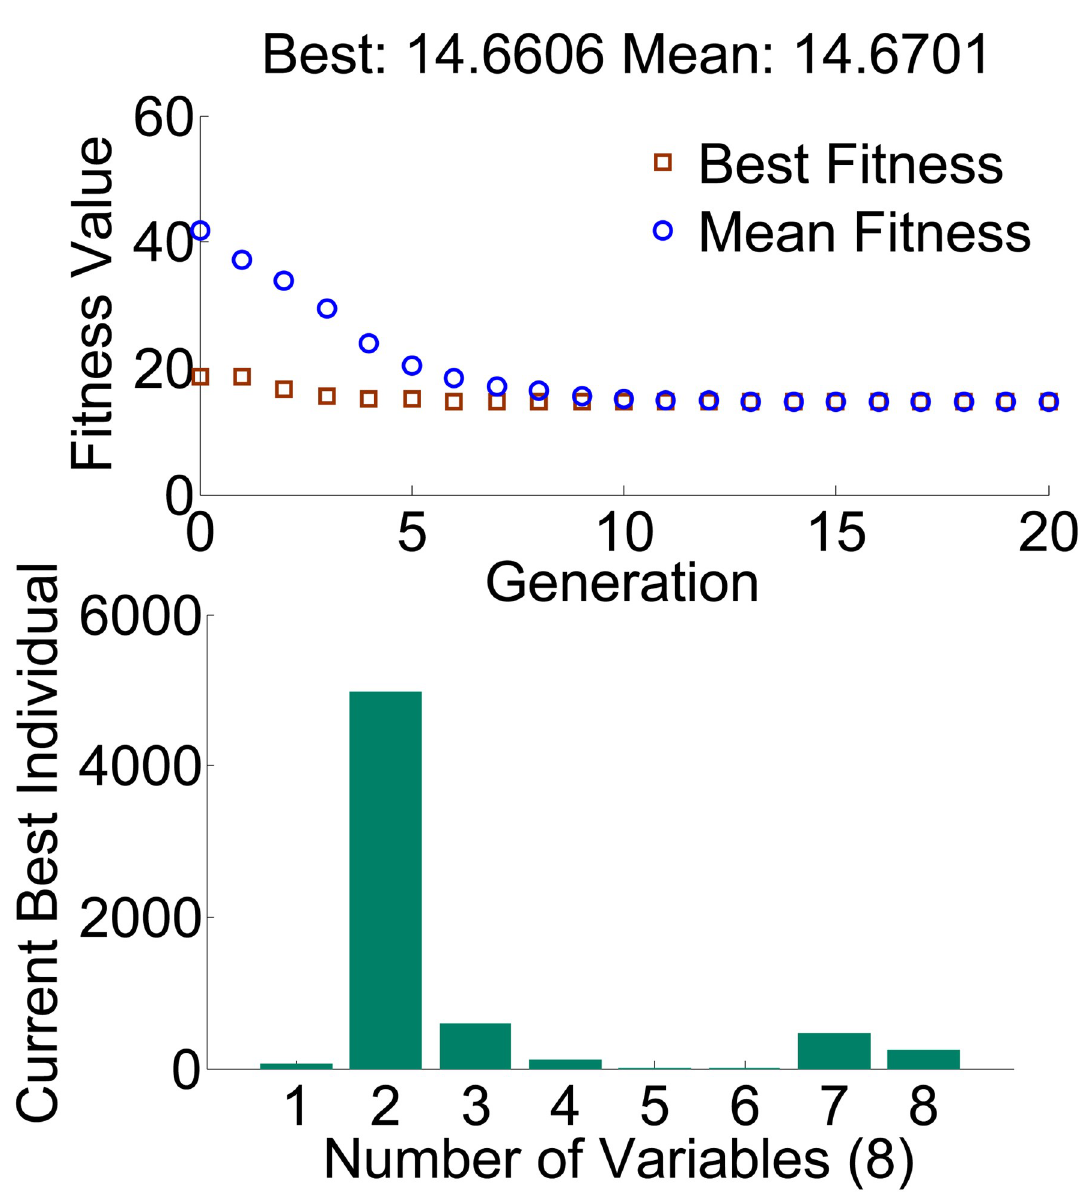
Fig 10. The best GA